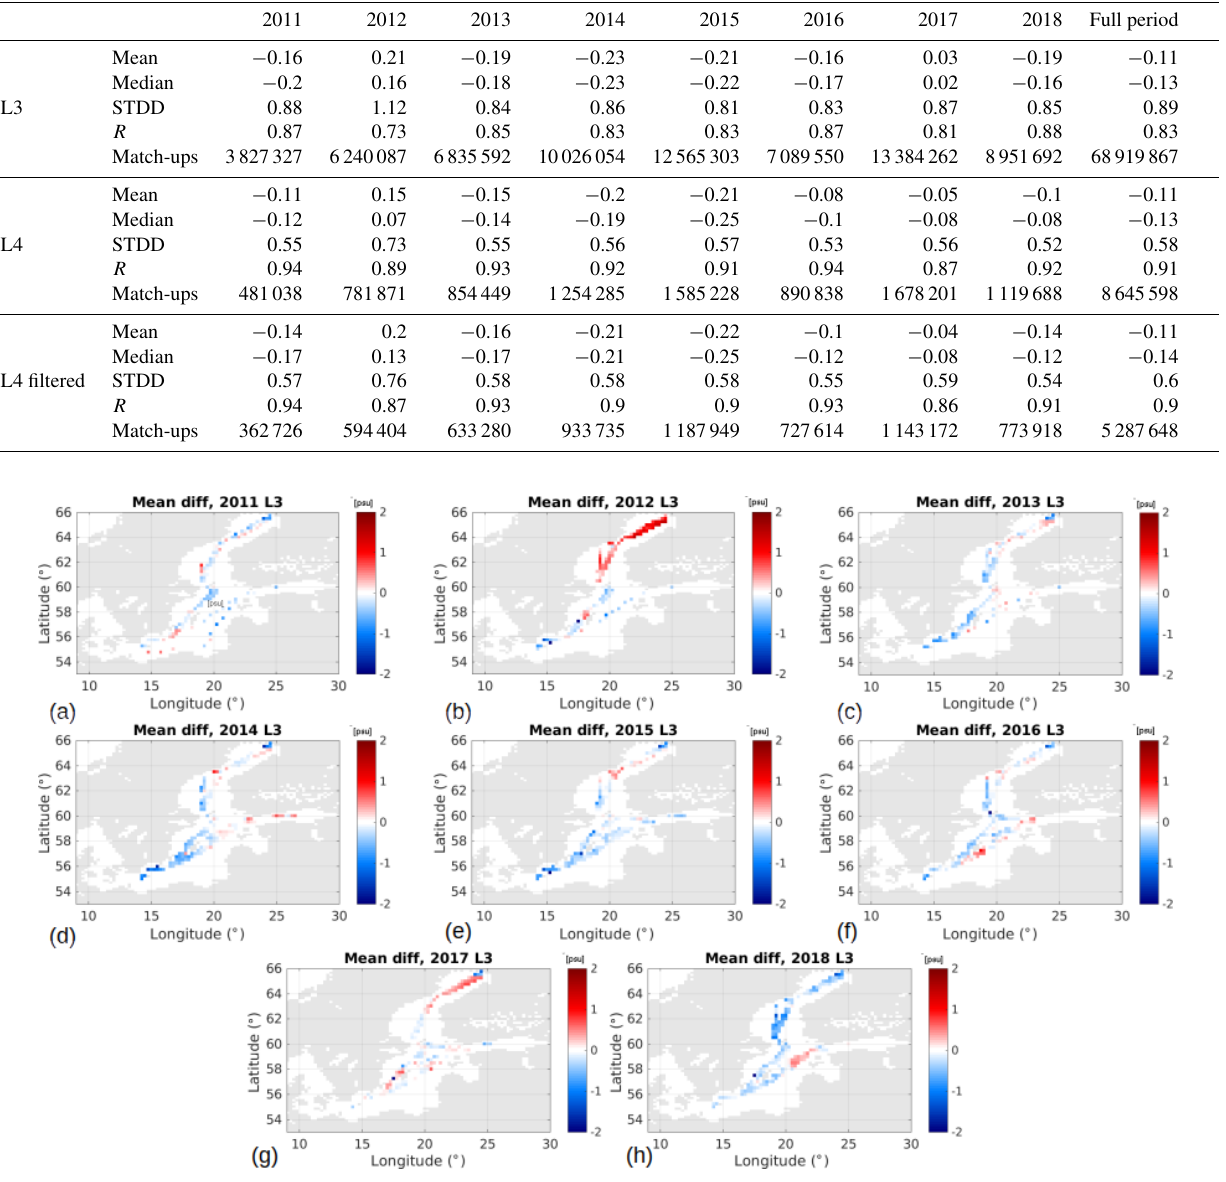
Table 3. Global statistics for Baltic+ L3, L4 and filtered L4 (not considering extrapolated measurements from reanalysis) SSS products against FerryBox in situ data. Note the high variability in the number of match-ups is due to the different cruises operated each year.